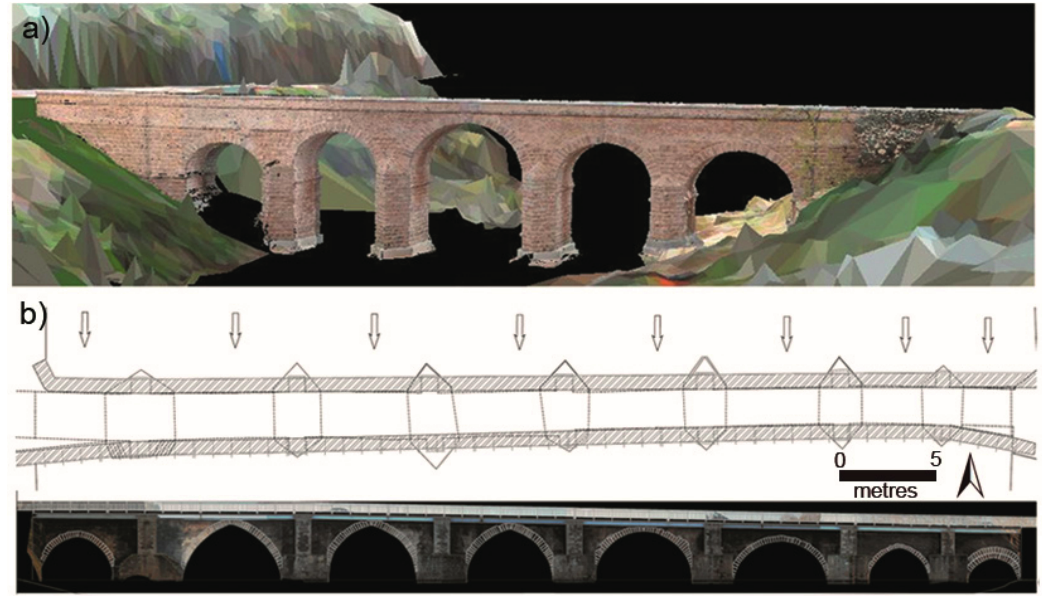
Figure 5. ( a ) Photorealistic model of the Segura Roman Bridge; ( b ) Detailed plans of the Lugo Roman Bridge